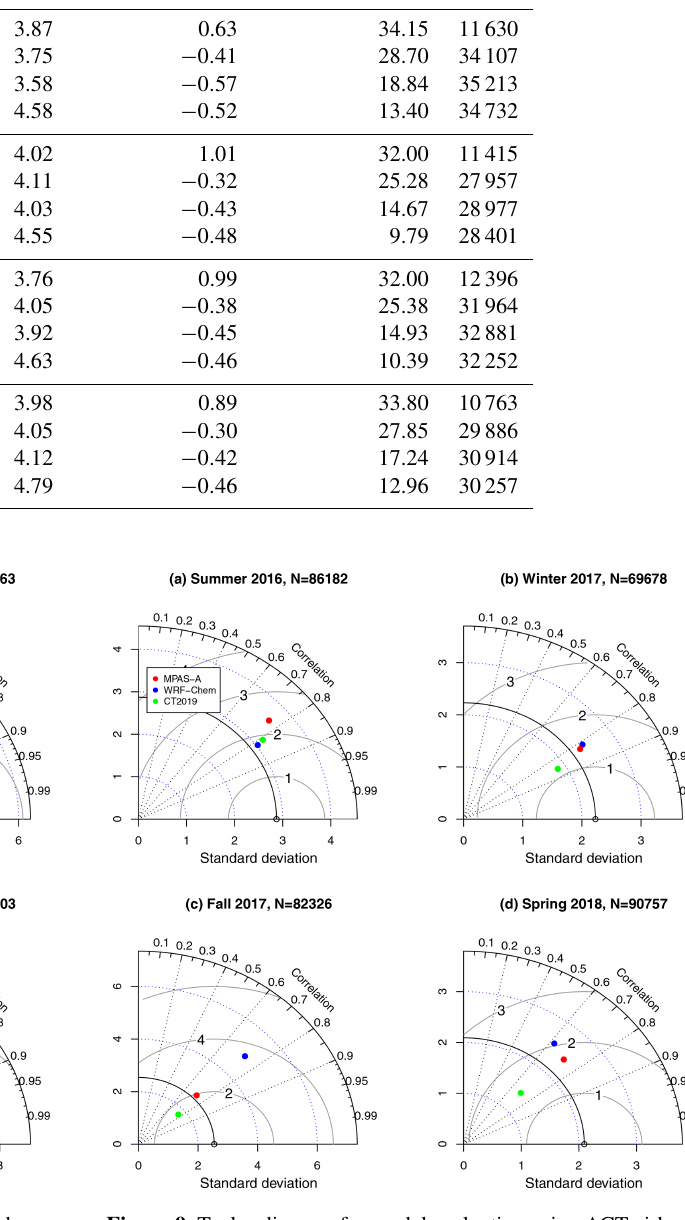
Figure 9. Taylor diagram for model evaluation using ACT airborne measurements in the free